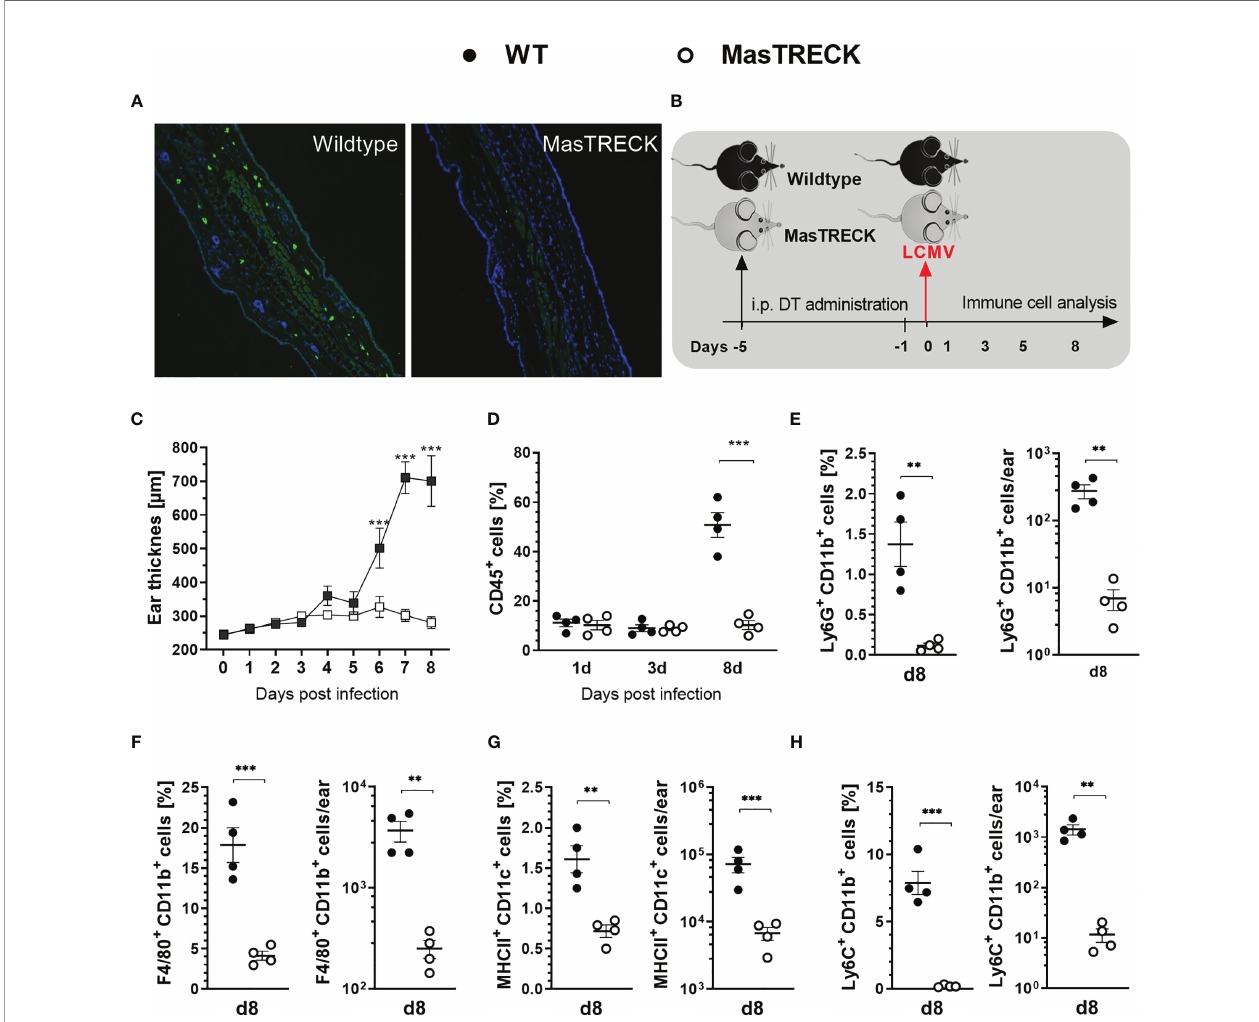
FIGURE 1 | Mast cells are crucial for immune cell recruitment to the site of LCMV infection. (A) Immunohistochemistry analysis of paraf fi n ear sections using Avidin- FITC and DAPI to assess MCs and cell nuclei, respectively after DT treatment. (B) Schematic experimental layout to analyze immune responses in intraperitoneally treated WT and MasTRECK mice for 5 consecutive days with 250 ng DT followed one day after by an intradermal LCMV infection into the ventral side of the ear pinna. (C) Ear thickness daily measured using a caliper during 8 days after LCMV infection. (D) Frequencies of CD45 + cells in the ear of WT and MasTRECK mice on day 1, 3 and 8 post LCMV infection analyzed by fl ow cytometry. Frequencies and absolute numbers of (E) neutrophils (Ly6G + CD11b + ), (F) macrophages (F4/ 80 + CD11b + ), (G) DCs (MHCII + CD11c + ) and (H) in fl ammatory monocytes (Ly6C + CD11b + ) in the ear of WT and MasTRECK mice assessed by fl ow cytometry on